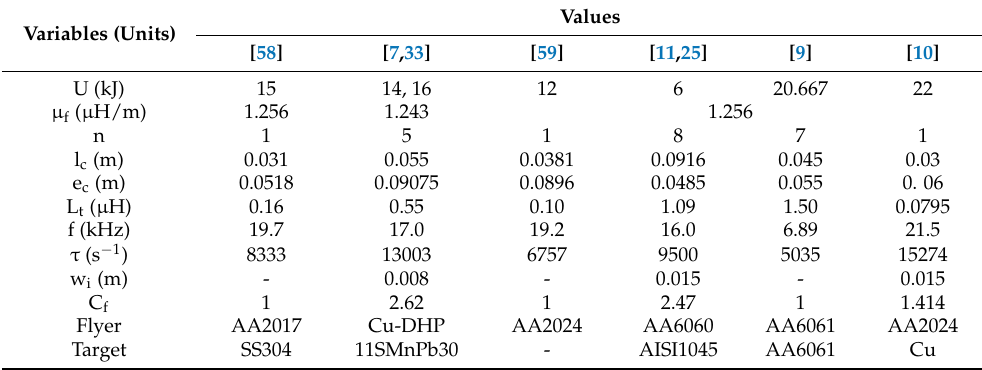
Table 5. Values used for calculation of the EM pressure (p) for MPW of tubes.